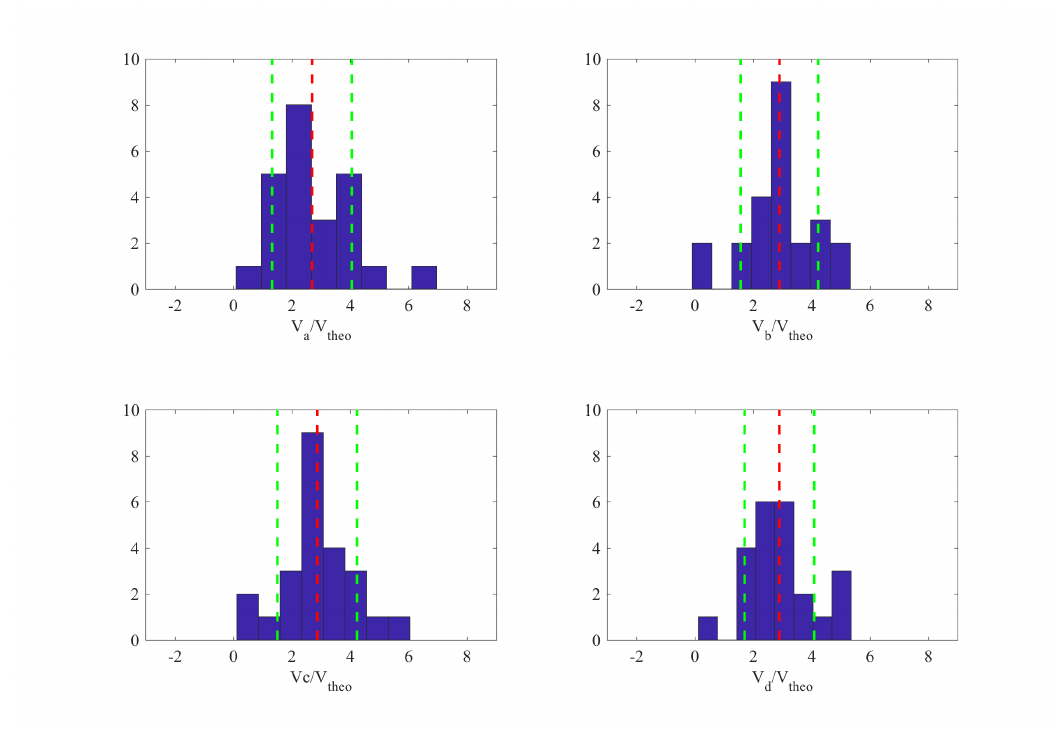
Figure 6. Distributions of the ratios between probe potential V i and the expected value V theo inside the plasma bubble for the CSES orbit n. 029301. Red vertical dashed lines indicate the mean value. Green vertical dashed lines indicate the range at one standard